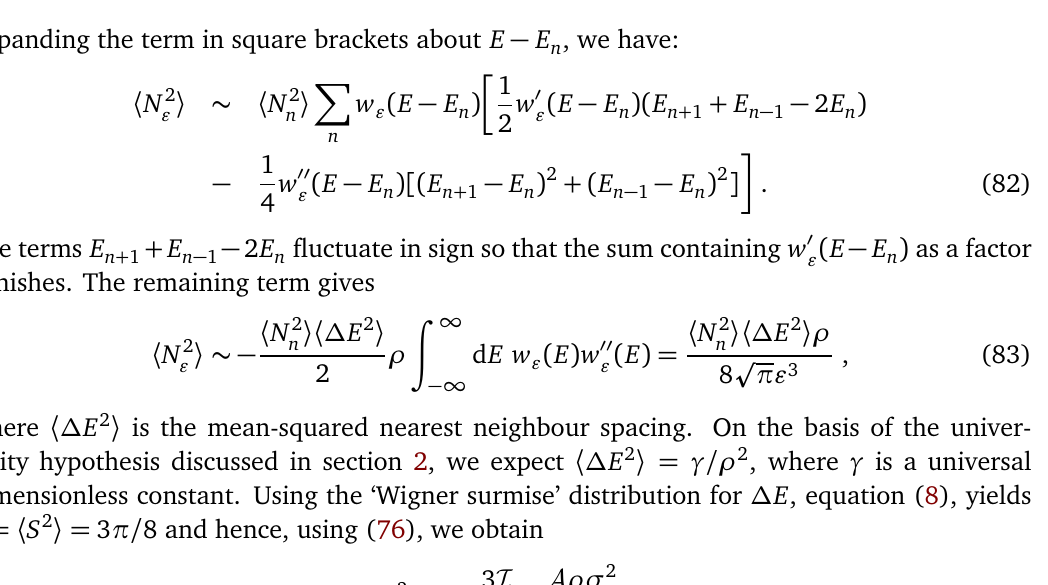
Figure 7: Numerical data and horizontal lines as in 5, except that data are shown for = 0, but for different correlation lengths energy single energy window based at E 0 ˜ θ = 1 / 2,1 ( M = 100) and ˜ θ = 1,2 ( M = 150). The energy window widths are equal, respectively for each M and y , to the second in the list of (cid:34) values shown in figure